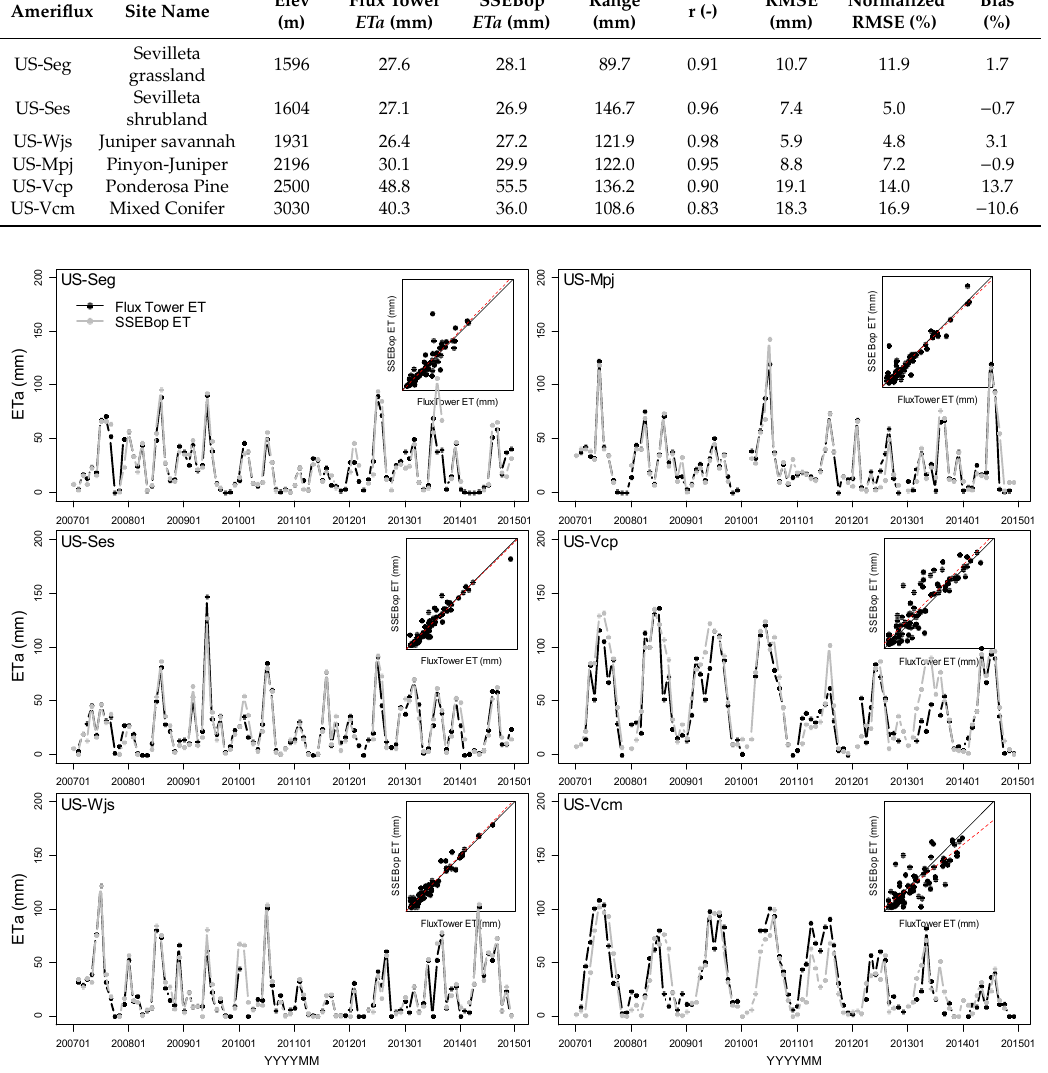
Figure 3. Comparison of monthly SSEBop ETa and observed ETa from the six eddy-covariance flux towers. The x-axis shows the date in 4-digit year (YYYY) and 2-digit month (MM) format.